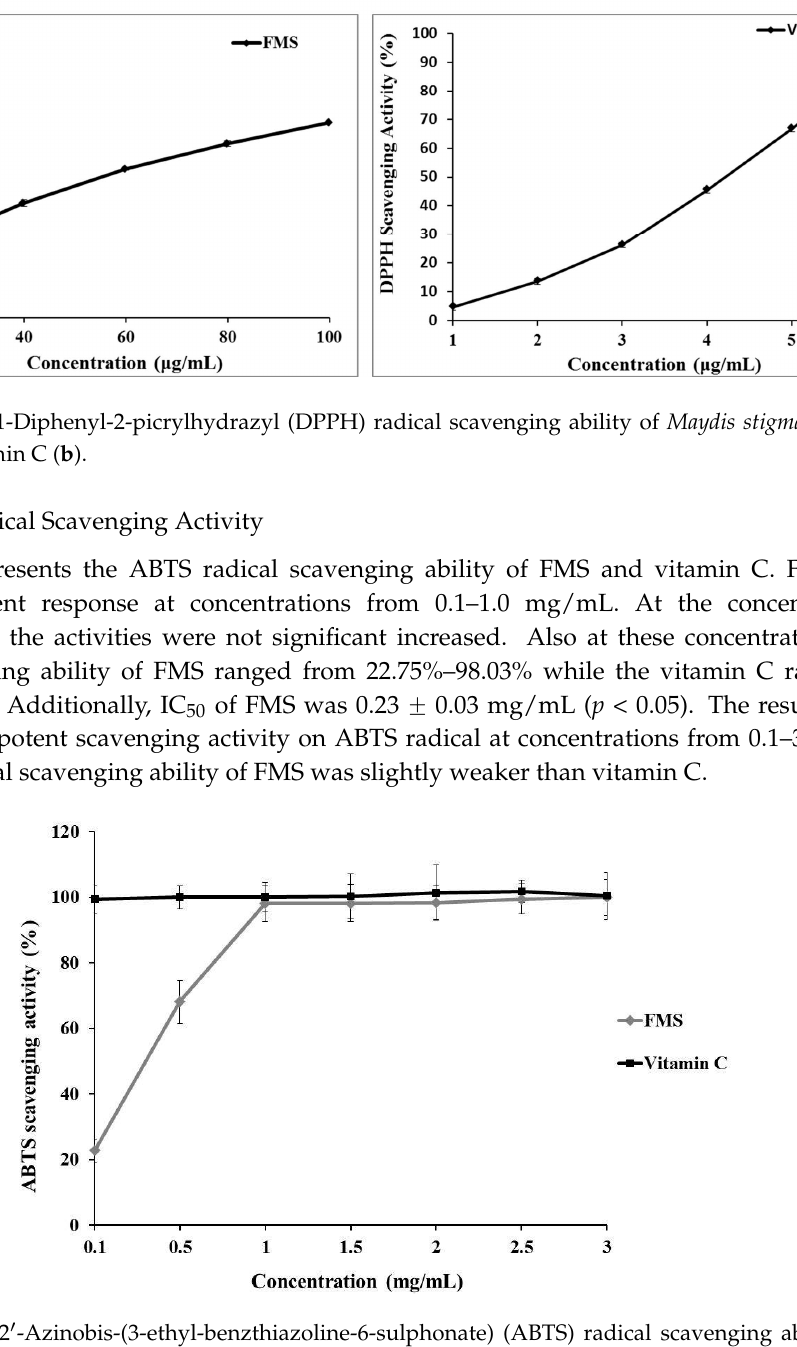
Figure 3. 2,2 ′ -Azinobis-(3-ethyl-benzthiazoline-6-sulphonate) (ABTS) radical scavenging ability of FMS and vitamin C.